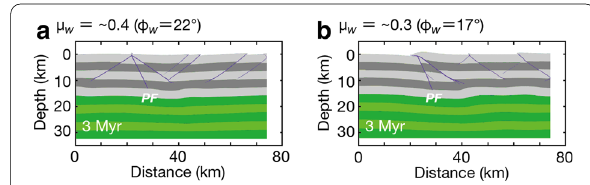
Fig. 9 Effect of different weakened friction coefficients μ w on the activity of a preexisting fault with a dip angle of 60°. a Case with μ w ~ 0.4 (weakened friction angle φ w = ( φ w 17°). The preexisting fault (PF) and newly formed faults (markers = with a cumulative strain larger than 1) are illustrated in dark